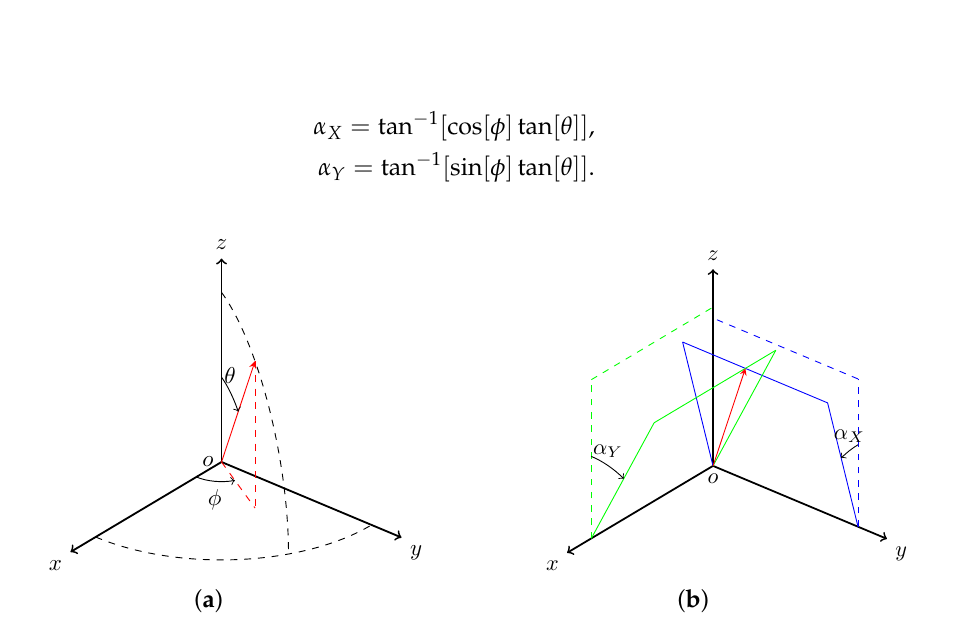
Figure 6. Convert ( a ) θ and φ in the spherical coordinate system to ( b ) α X and α Y in the X / Y angle